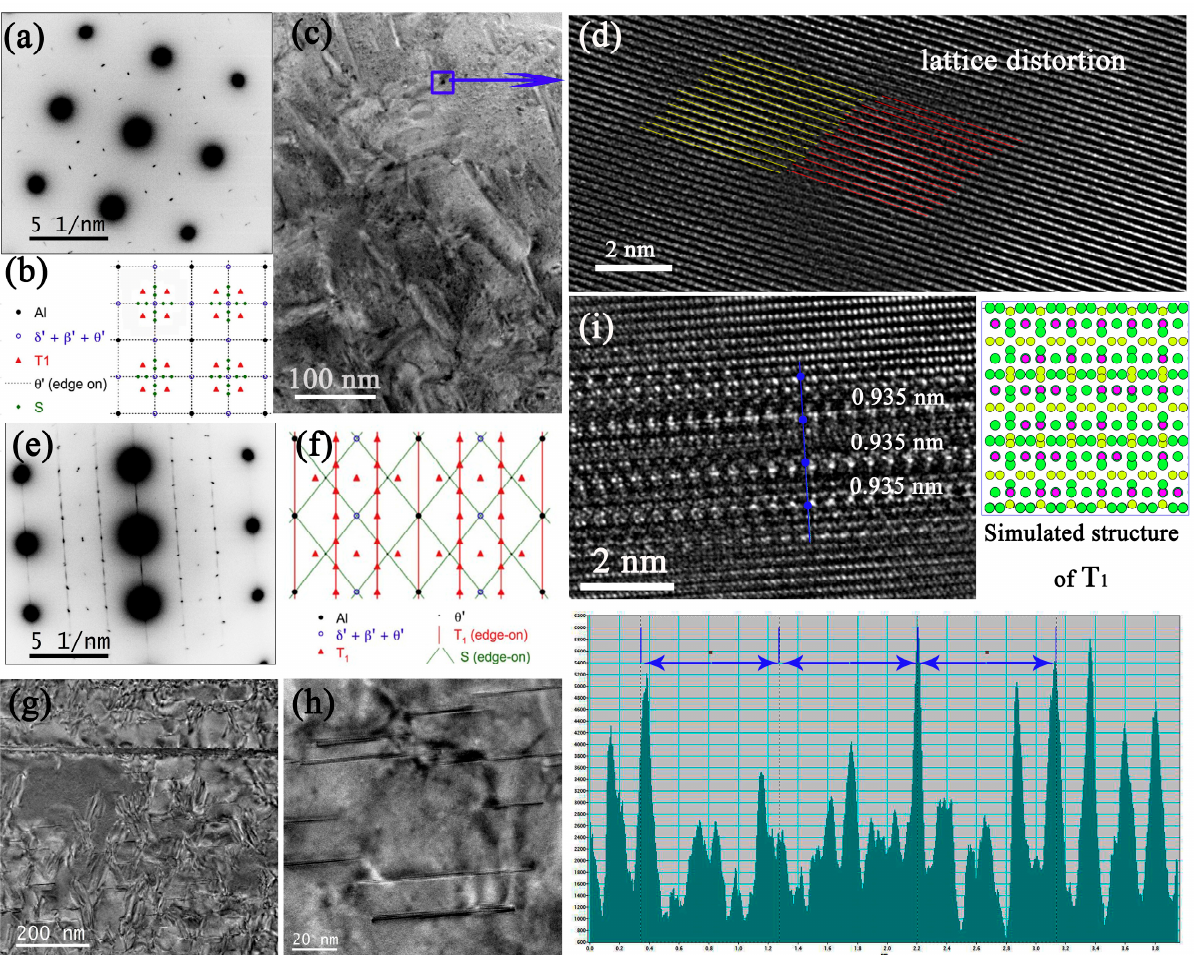
Figure 14. TEM analysis of 9A# after 12 h creep. ( a ) SADP under [100] α and ( b ) corresponding schematic SADP. ( c ) BF viewed in [100] α and ( d ) HRTEM of the blue box in ( c ). ( e ) SADP under [112] α and ( f ) corresponding schematic SADP. ( g , h ) BF images viewed in [112] α . ( i ) HRTEM of a secondary T 1 phase captured in [112] α .